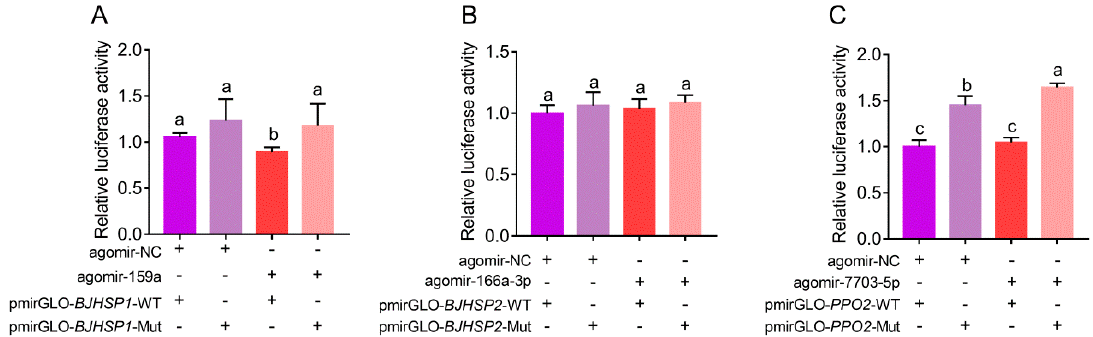
Figure 4. Determination of interaction of miRNAs and target binding sites. ( A – C) . Luciferase assays of miR159a agomir ( A ), miR166a-3p agomir ( B ) and novel-7703-5p agomir ( C ), together with the wild-type (WT) and mutant (Mut) binding sites. Agomir-NC was used as the negative control miRNA. The mean of the relative luciferase activities of the control group was set to 1. Data were presented as mean ± SD (one-way Analysis of Variance (ANOVA) followed by Tukey’s multiple comparisons, different letters above the columns indicated significant difference at p < 0.05).